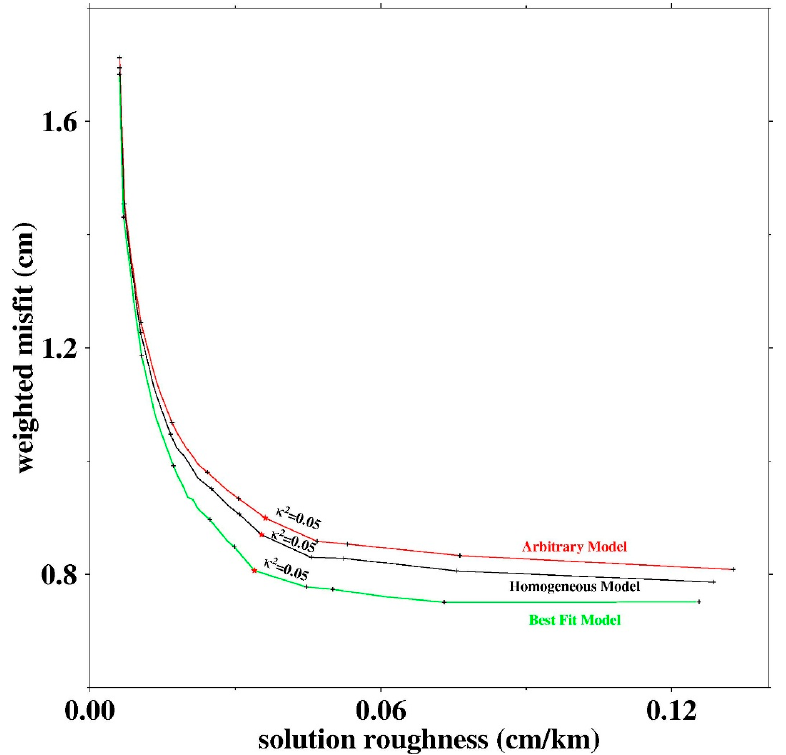
Figure 9. Trade-off curves of three models between the weighted misfit and the Figure 10